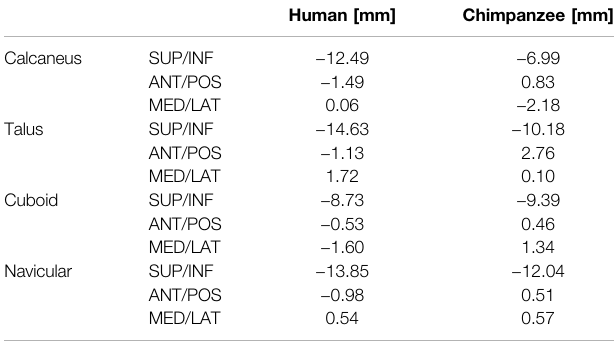
TABLE 1 | Translational displacements of foot tarsal bones (calcaneus, talus, cuboid, and navicular) during quiet standing of human and chimpanzee; positive values indicate superior, anterior, medial directions.